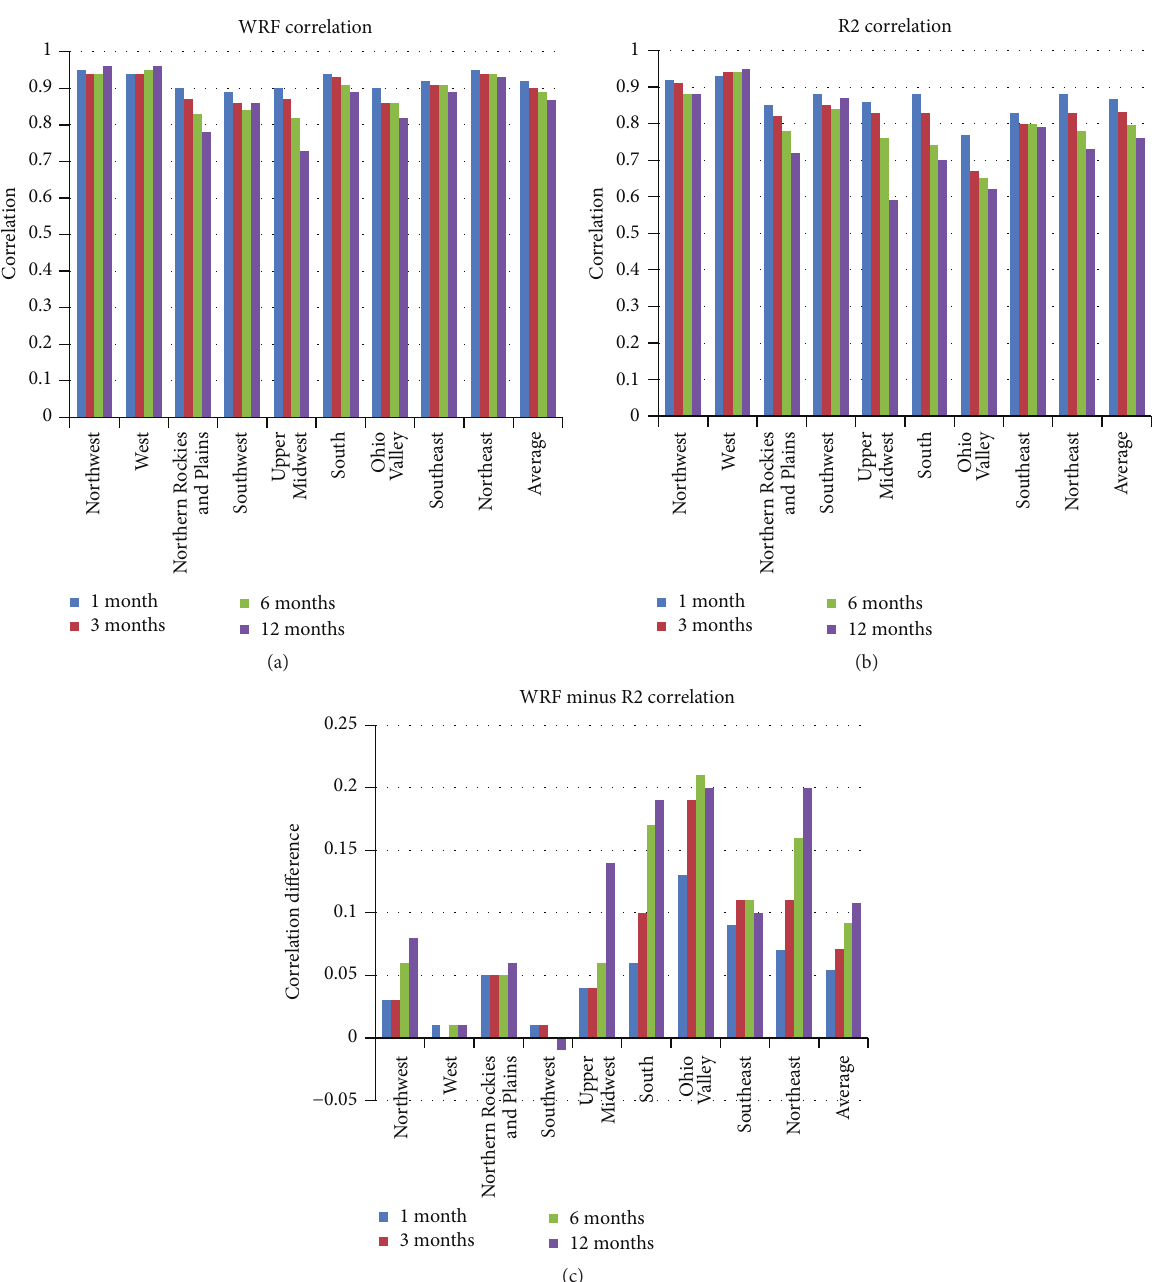
Figure 4: SPI correlation coefficient between (a) WRF and PRISM and (b) R2 and PRISM for 1-, 3-, 6-, and 12-month accumulation periods averaged over each NCDC climate region. (c) Difference between WRF and R2 correlation coefficient (WRF minus R2) for the same periods and regions as in (a) and